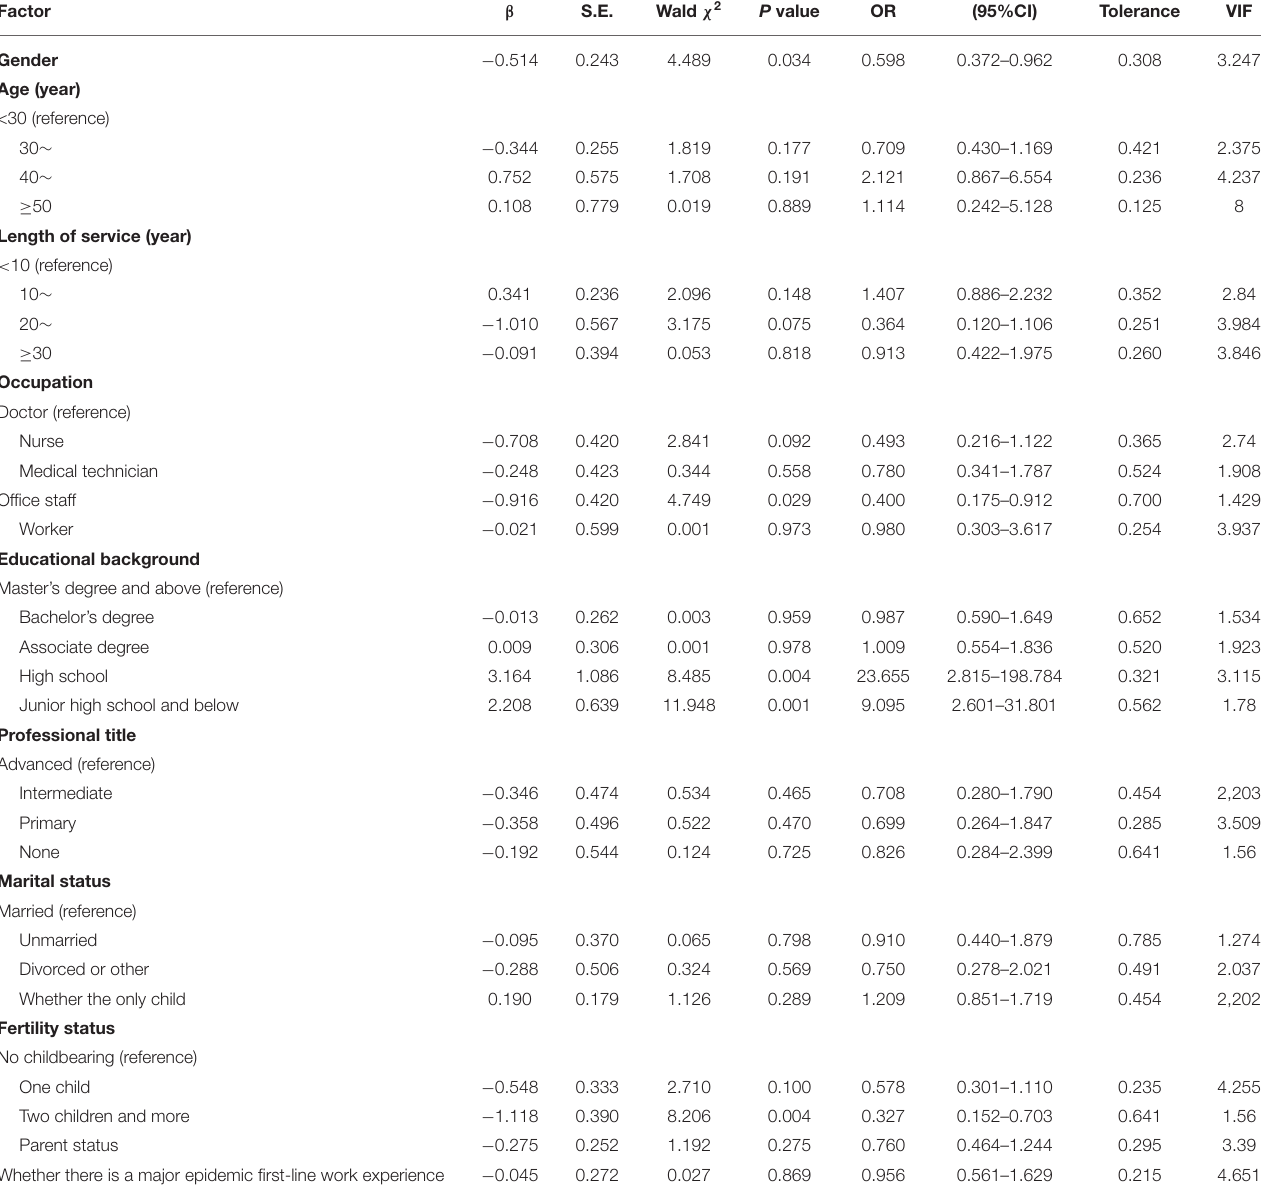
TABLE 4 | Logistic multivariate analysis of factors affecting the mental health of hospital staff. Factor β S.E. Wald χ 2 P value OR (95%CI) Tolerance